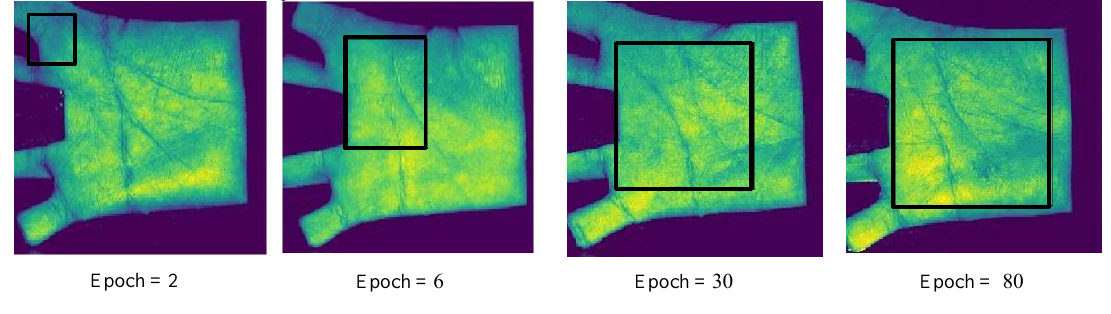
Figure 5. Examples of predicted ROIs for different epochs.